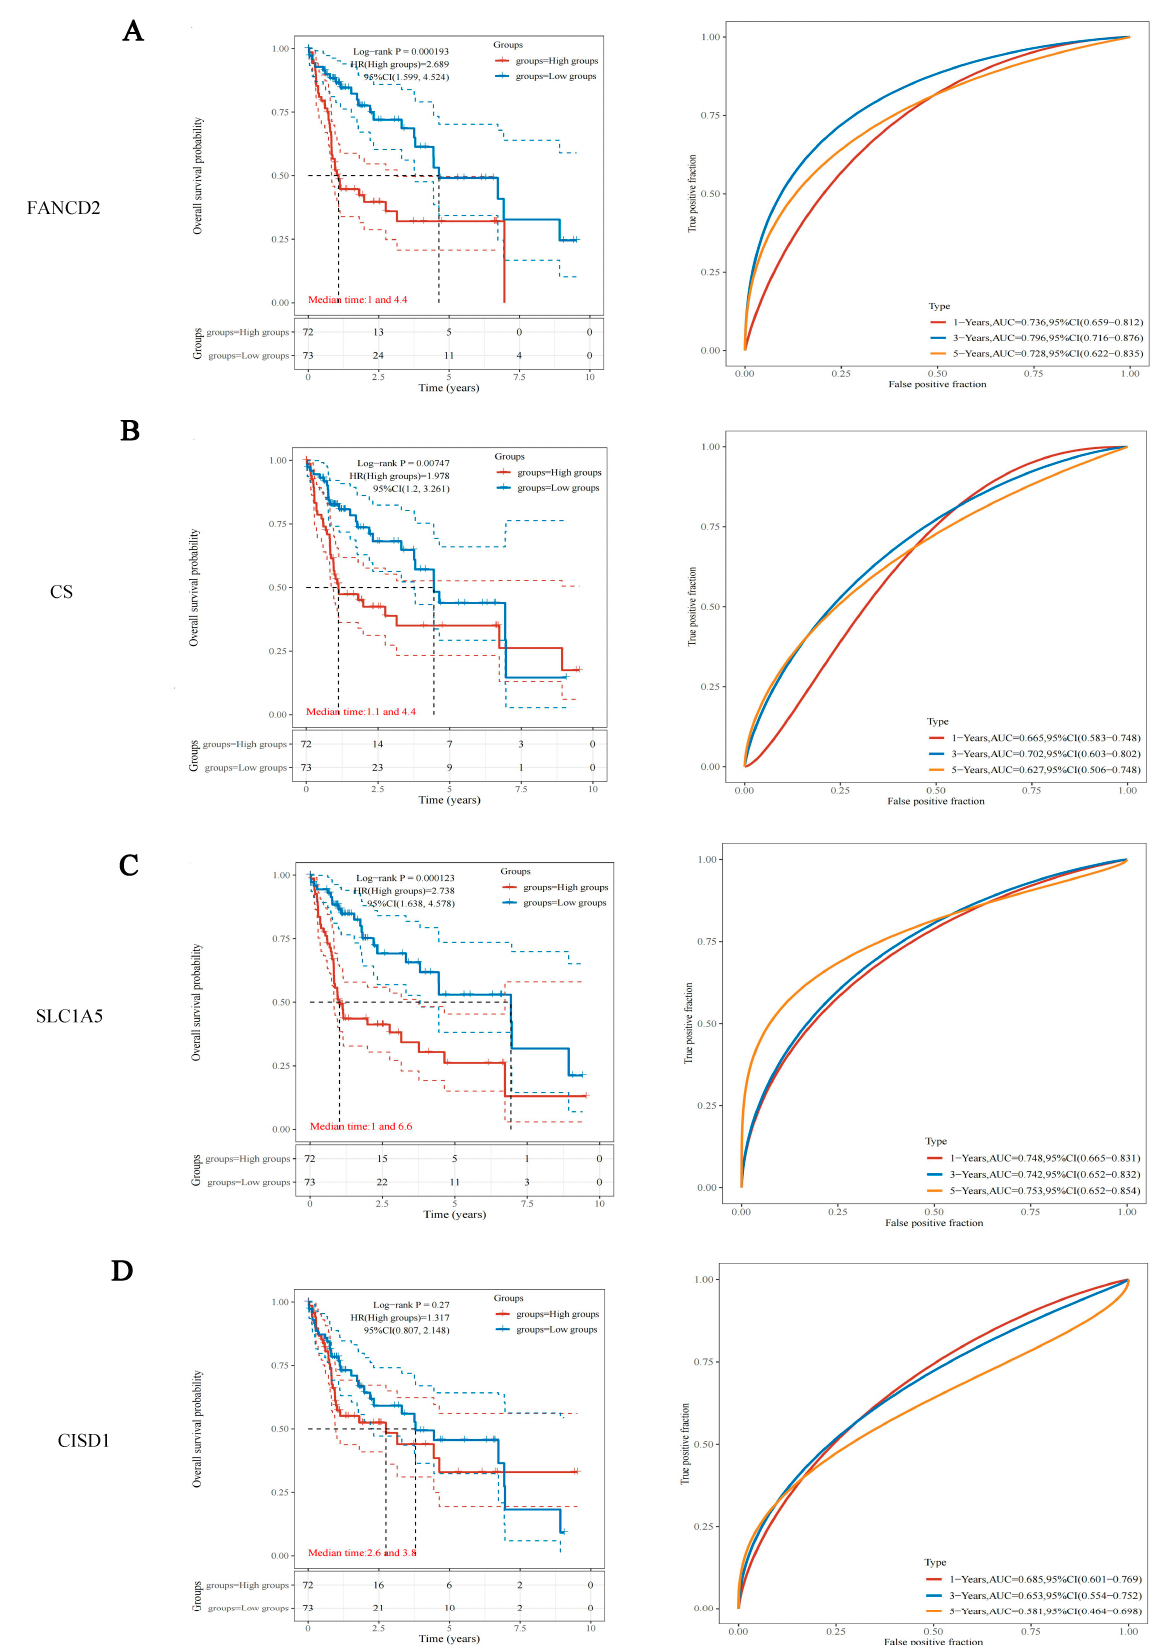
Figure 2. Overall survival analysis of FANCD2, CS, SLC1A5 and CISD1 in HBV-related